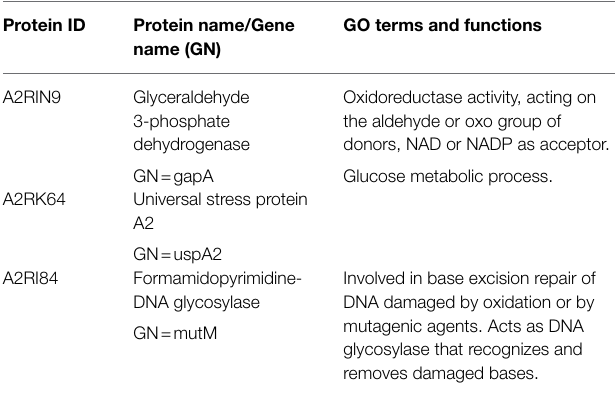
removes damaged bases.